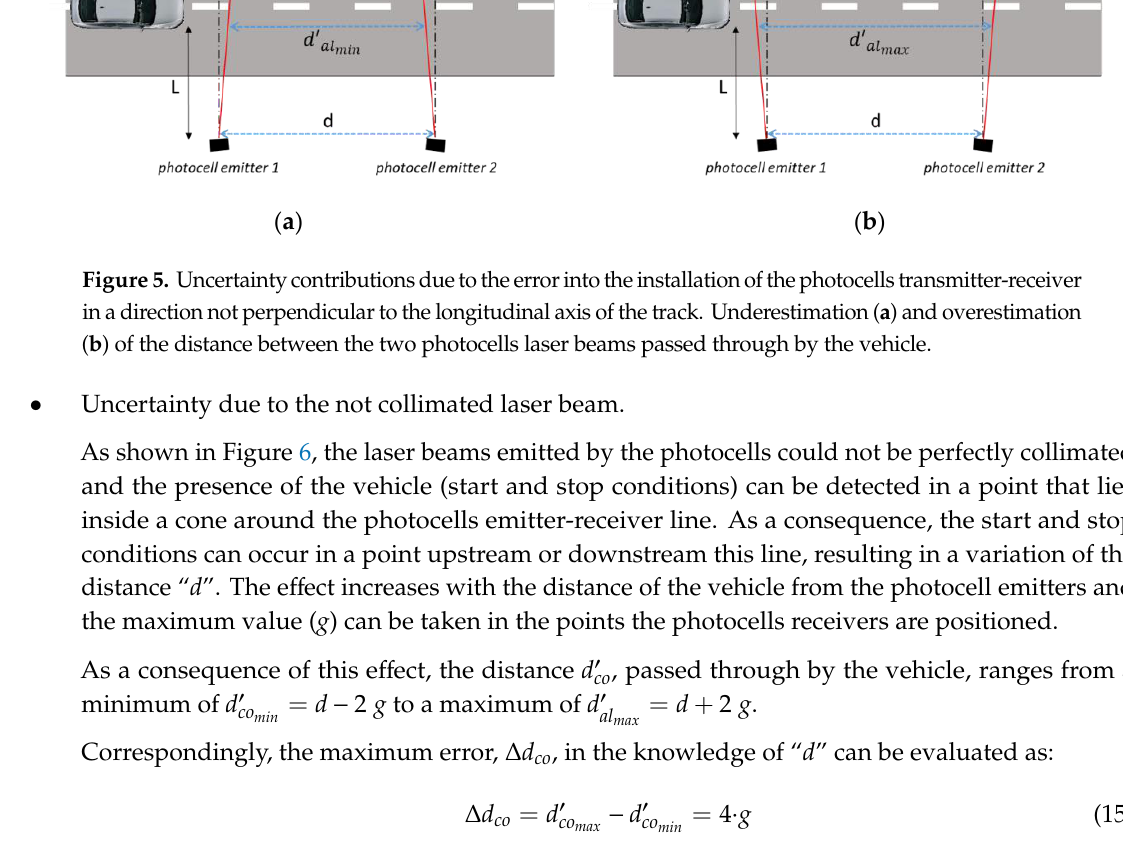
in a direction not perpendicular to the longitudinal axis of the track. Underestimation ( a ) and overestimation